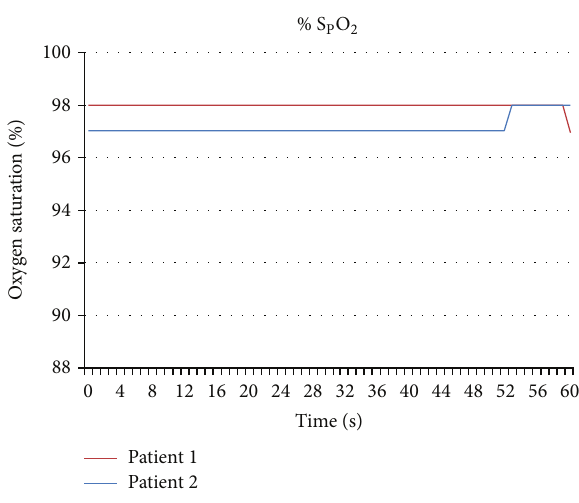
Figure 22: Comparison of oxygen saturation profiles for the two